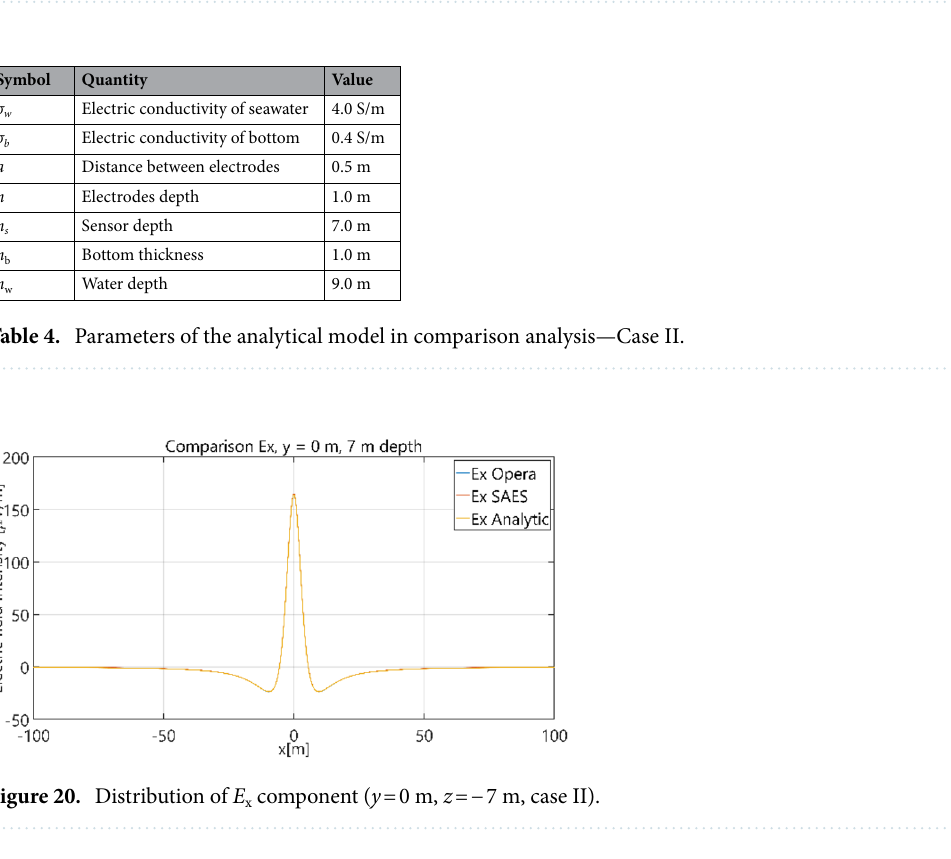
Table 3. Relative differences between results of the analytical (three-layer) model and numerical FEM and BEM models—Case I.